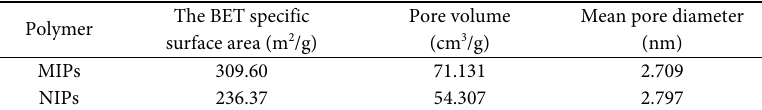
Table 3. BET analyses of the MIPs and